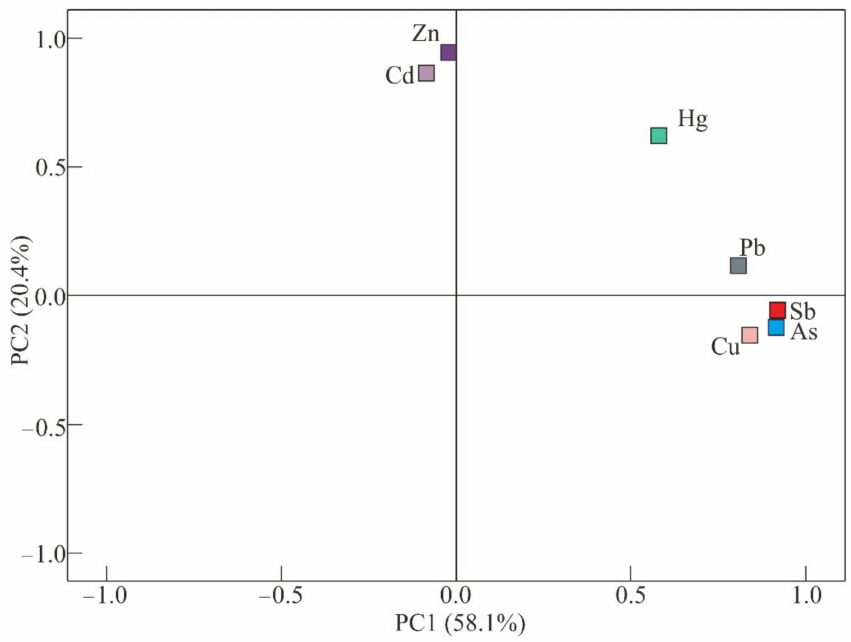
Figure 5. Factor loadings of two principle components after varimax